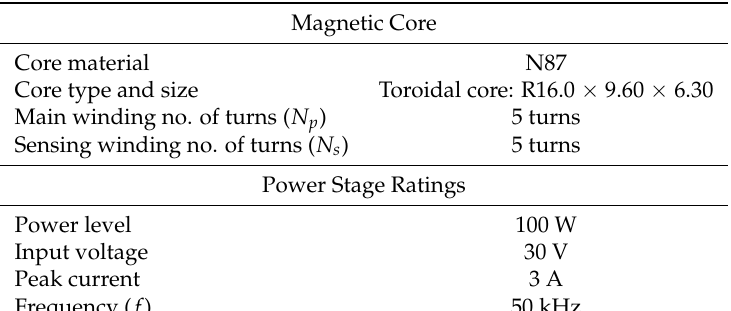
Figure 5. Experimental setup used to measure the B ( H ) curve. Table 2. Specifications of the test setup developed to measure the B ( H )